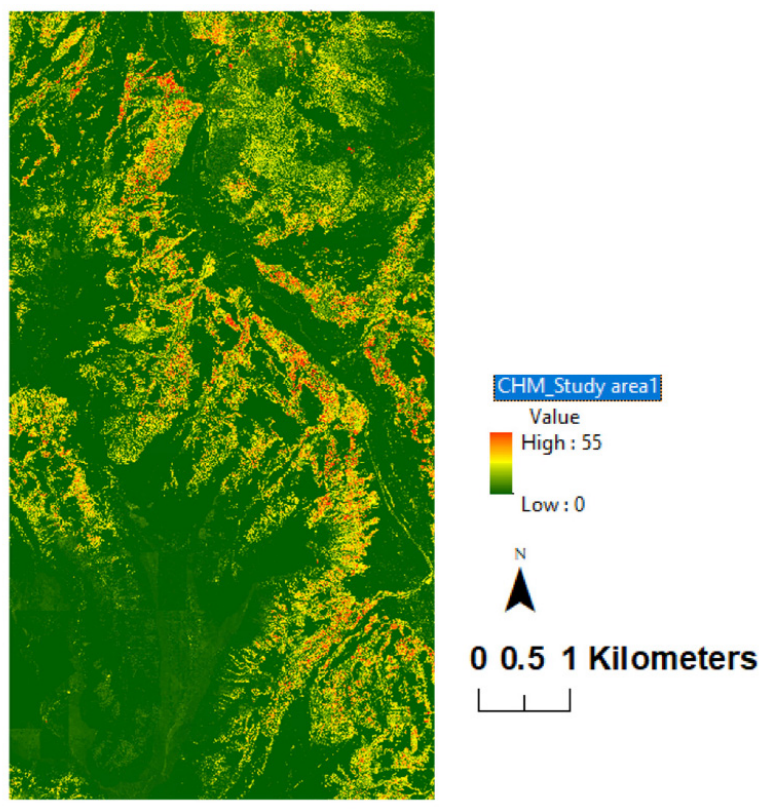
Figure 3. Canopy Height Model (CHM) of study area 1 derived from Airborne Laser Scanning (ALS) based point clouds.